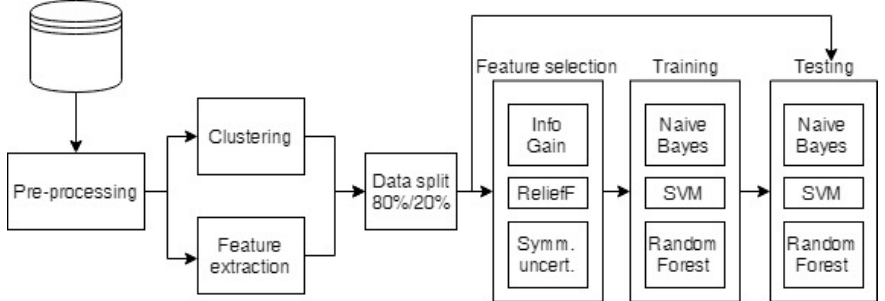
Figure 2. Diagram of the data analysis process.